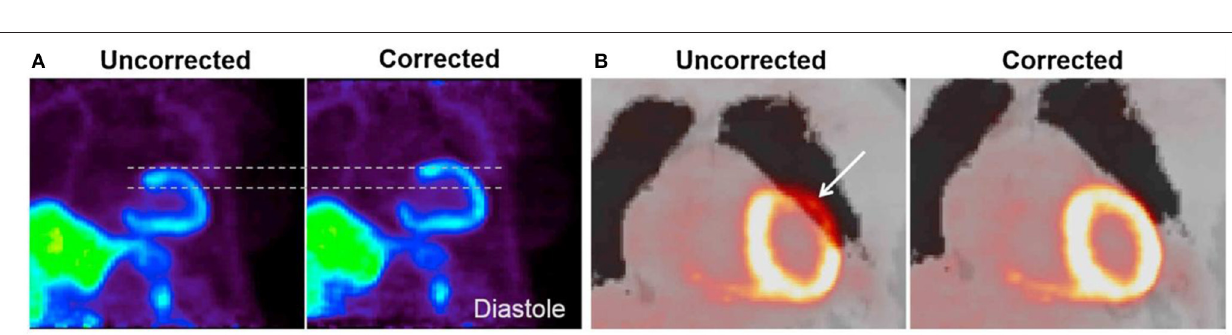
FIGURE 4 | Illustration of the partial volume effect (PVE) in medical imaging. (A) A circular source of uniform activity in a warm background region yields a measured image in which part of signal emanating from the source is observed outside (spill-out) while part of the background signal is observed within the lesion (spill-in). (B) The tracer distribution is sampled on a voxel grid and the contours of the voxels do not match the actual contours of the tracer distribution (Tissue-fraction).